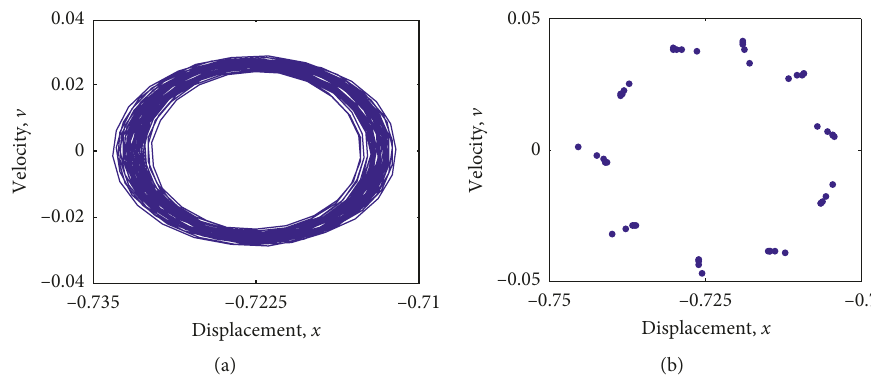
Figure 13: Dynamic response of the system at ω � 2.8. (a) Phase diagram. (b) Poincar´e